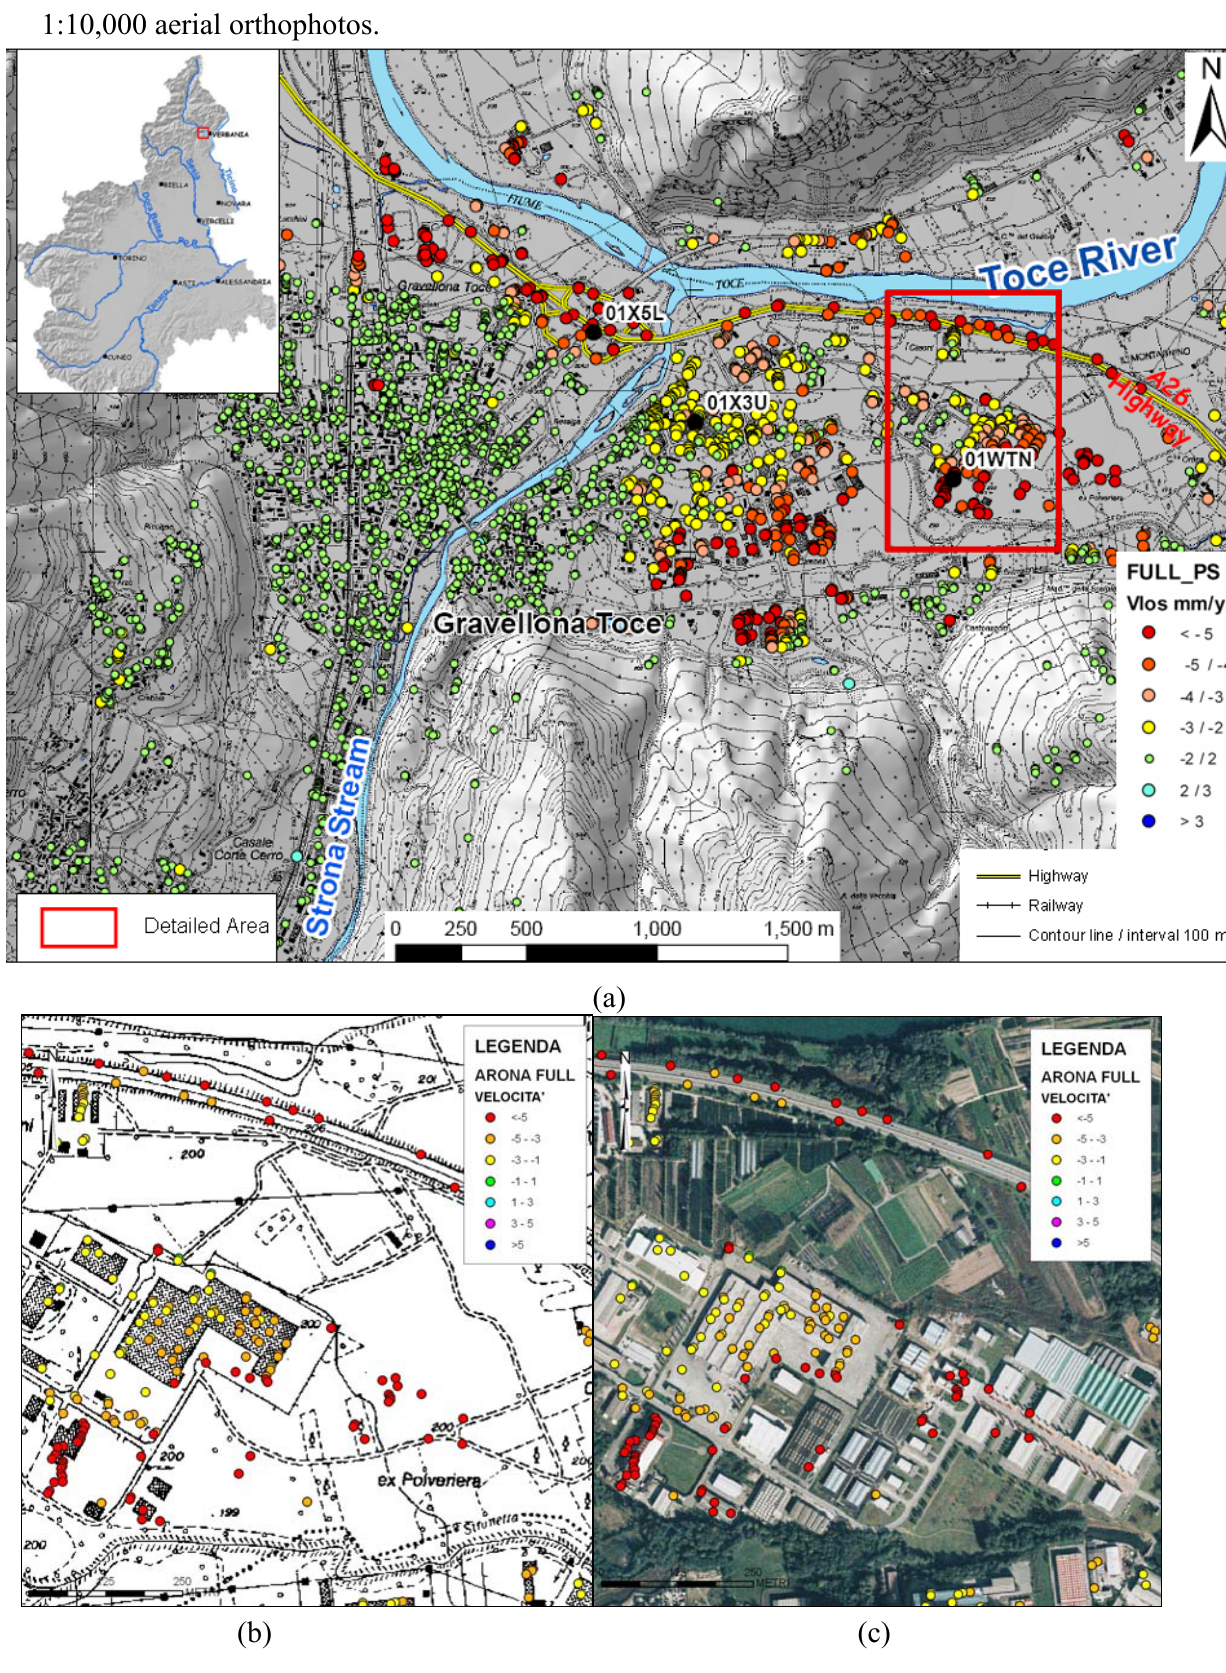
Figure 14. (a) Strona Stream alluvial fan. (b) Detail of the area with new buildings on the 1984 1:10,000 topographic map. (c) Detail of the area with new buildings on the 2000 1:10,000 aerial